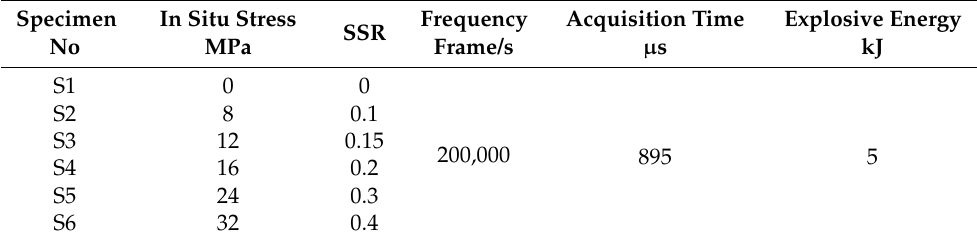
Table 2. Experimental scheme.